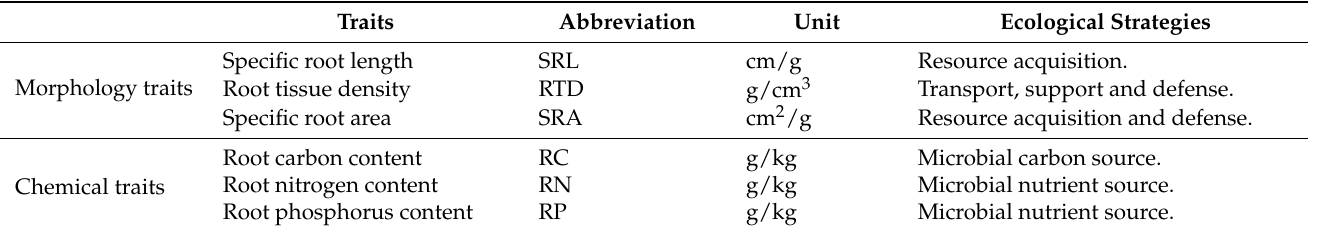
Table 2. Fine root functional traits selected and ecological strategies. Traits Abbreviation Unit Ecological